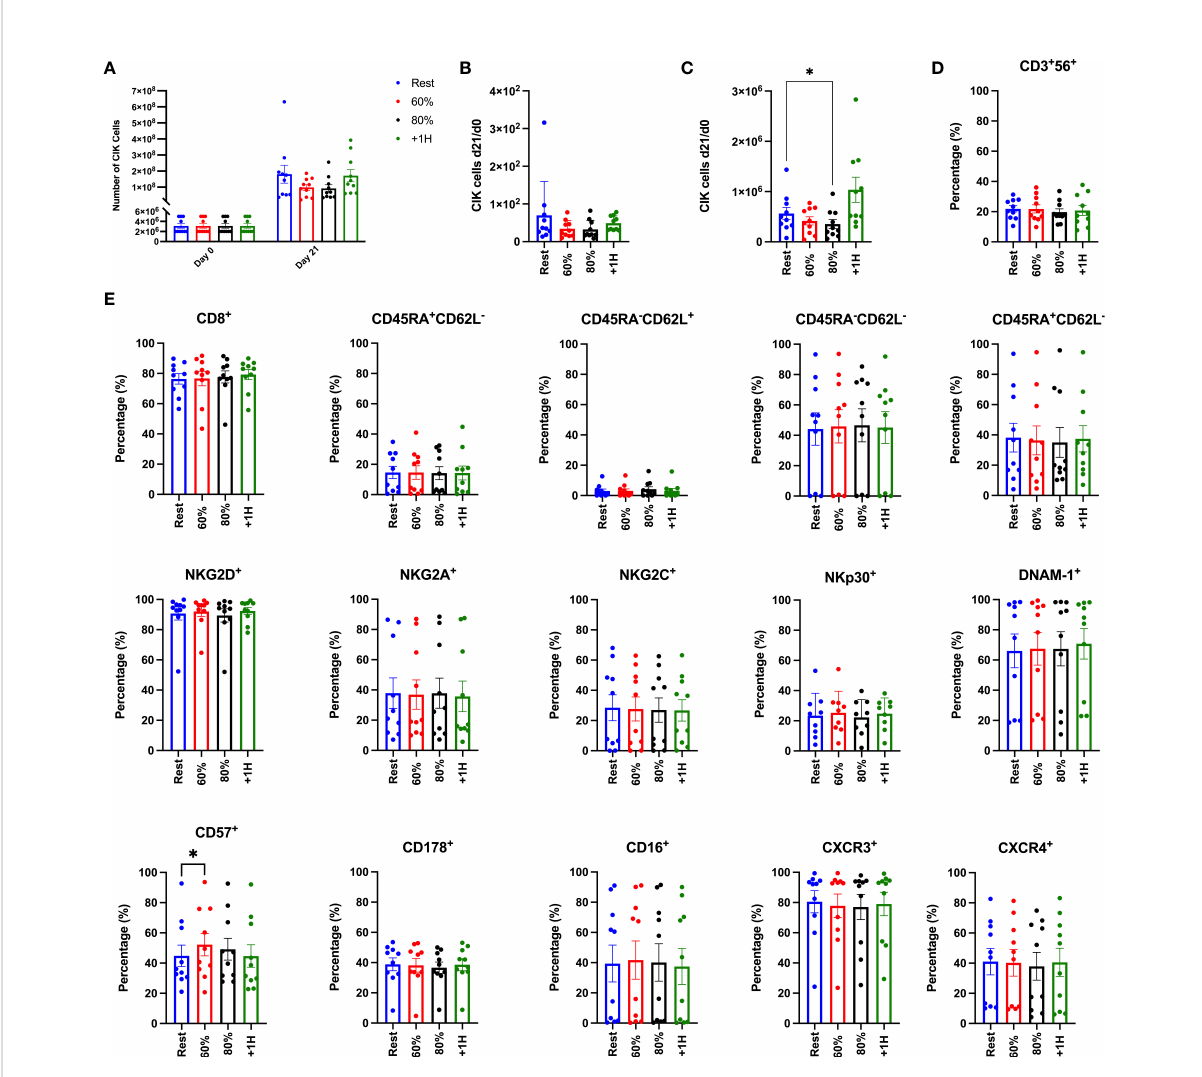
FIGURE 6 Enumeration and associated phenotypes of ex vivo expanded CIK cells. (A) The total number of PBMCs utilized for expansion on Day 0 and the total number of CIK cells generated in the expanded cell products after 21 days ( n = 10). (B) The number of CIK cells generated at Day 21 divided by the number of CIK cells in the PBMC fraction at Day 0. (C) The number of CIK cells generated at Day 21 divided by the number of CIK cells in the NKT-cell fraction at Day 0. (D) The proportion of CD3 + CD56 + expression on the total CIK cell population. (E) The percentage of surface markers expressed on the CD3 + CD56 CIK cell population on day 21. Differentiated T-cells are phenotyped as follows: naïve (CD45RA + CD62L + ), central memory (CM; CD45RA - CD62L + ), effector memory (EM; CD45RA - CD62 - ), terminally differentiated effector memory (EMRA; CD45RA + CD62L - ). Surface expression was determined by fl ow cytometry and error bars are represented as mean ± SEM. Signi fi cance is indicated by *( p <